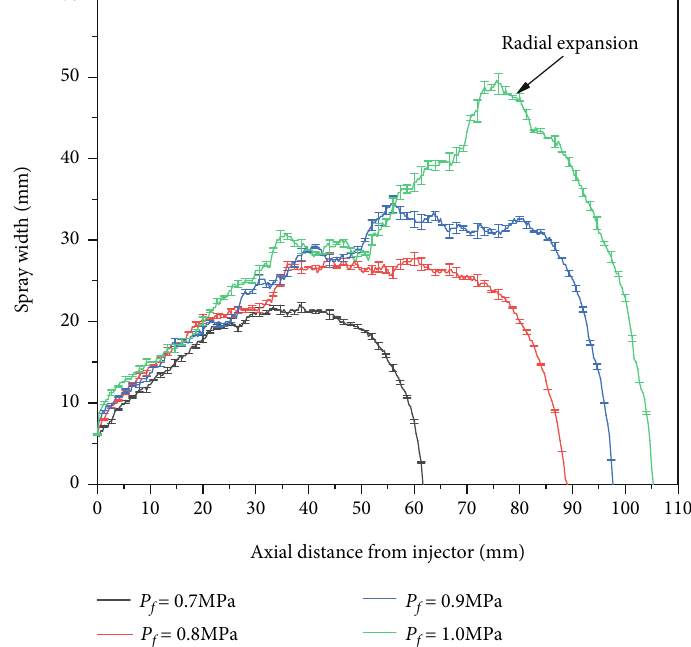
= 298K , Δ T = 4 : 0 ms f f